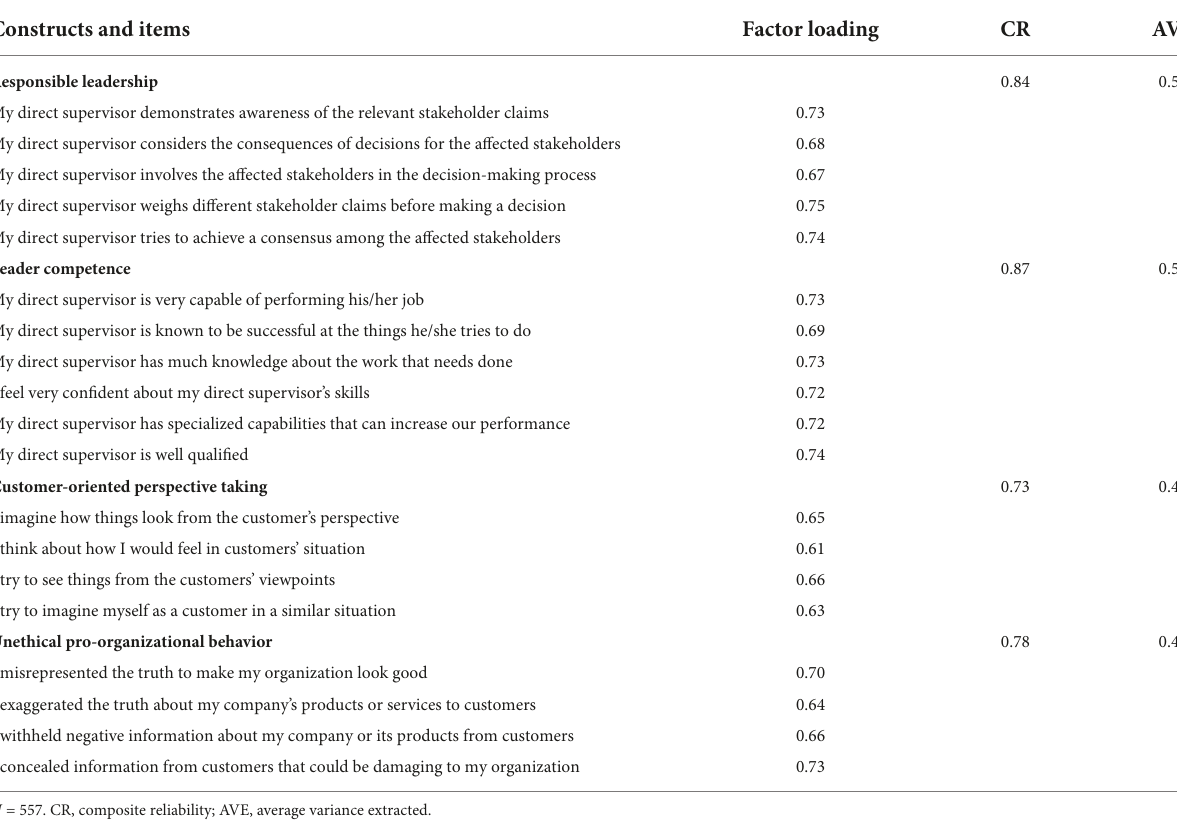
TABLE 2 The convergent validity test results.